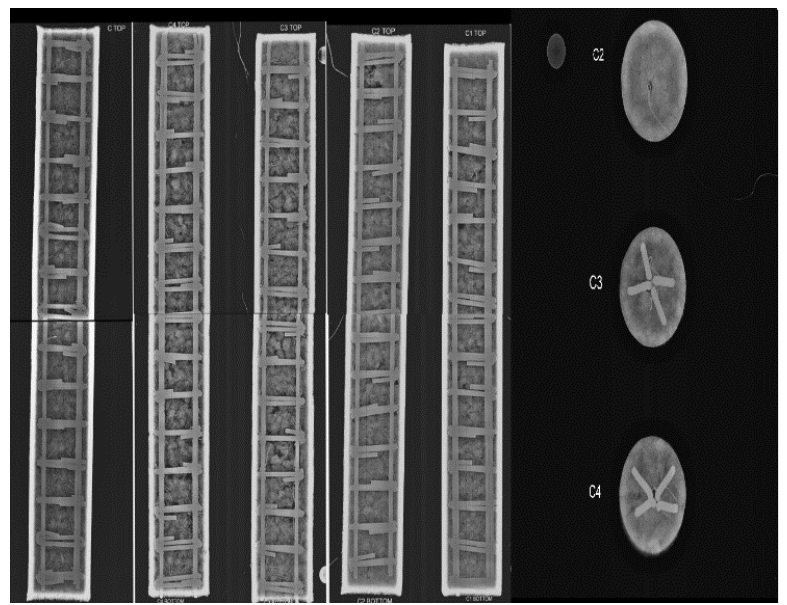
Figure 31. X-ray images of the column specimens.